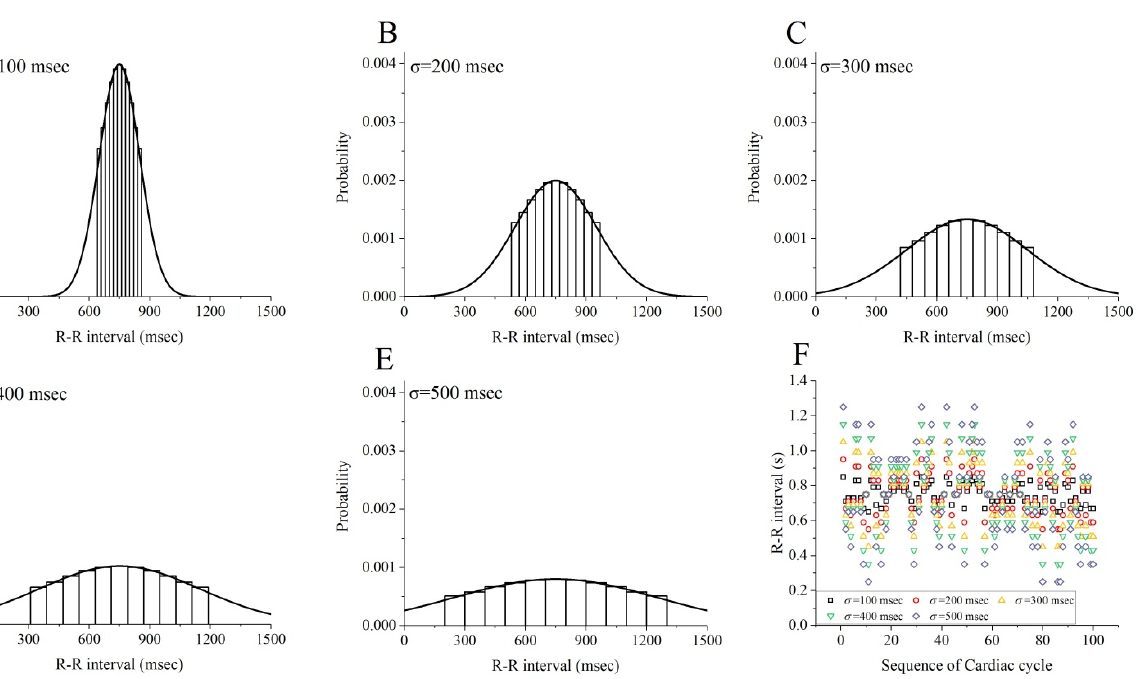
Figure 2. Probability densities and distribution histograms of cardiac R-R intervals with µ = 750 ms and σ being set to 100 ms ( A ), 200 ms ( B ), 300 ms ( C ), 400 ms ( D ) and 500 ms ( E ), respectively, and randomly sampled R-R intervals for 100 cardiac cycles ( F ). It is noted that the histograms only show the probabilities of R-R intervals falling in the range from µ − σ to µ + σ .